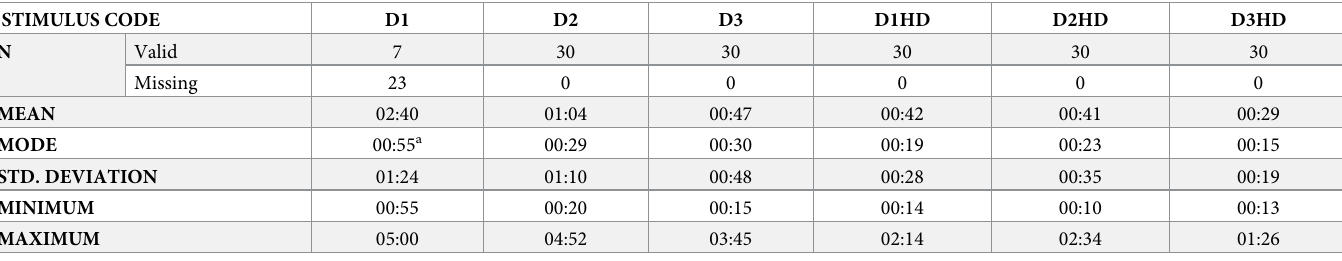
In conclusion, in case of point symbols, using height differentiation, while reducing dis- tances between symbols, improves the identification process of point symbols in relation to the variants with larger distances between the symbols without height differentiation. The second task that required identification of large area symbols was fairly easy for all the participants and the average solving times were almost the same across all the stimuli variants that we analysed (21–28 seconds: Table 6). The differences between times of identification of area symbols in stimuli variants are not statistically significant (Friedman’s test χ 2 (5) = 7.294; p > 0.05). The times required for solving this task depended more on the scanning technique used than the way the particular stimulus was designed. The third spatial task required the readers to track a path from starting point to the goal. To make things harder, the goal was hidden in the heights (zig-zag pattern). Thus, we can observe the impact of both increased minimum distances and height differentiation applied on the average results. For most participants (76.6%), solving this task on the D1 stimulus variant was impossible (cf. Tables 7–9). For all other samples we can observe slightly lower average solving times for stimuli variants with height differentiation applied (D1HD, D2HD, D3HD). The dif- ferences in the times of identification of line symbols were statistically significant (Friedman’s test χ 2 (4) = 18,554; p < 0.05). According to the results of pairwise Wilcoxon Signed-Rank tests with a BH correction (Tables 8 and 9), tracking the path (line symbols) was the most effective when participants used stimuli variants with height differentiation applied (average solving time for D3HD: 00:29). Moreover, there were significant differences between average solving times for D3HD in comparison with D2HD and D1HD: 00:12 (Z = 3.557; p < 0.05) and 00:41 (Z = 3.929; p < 0.05) respectively. Differences between D1HD and D2HD in solving times were not statisti- cally significant. Table 7. Task 3